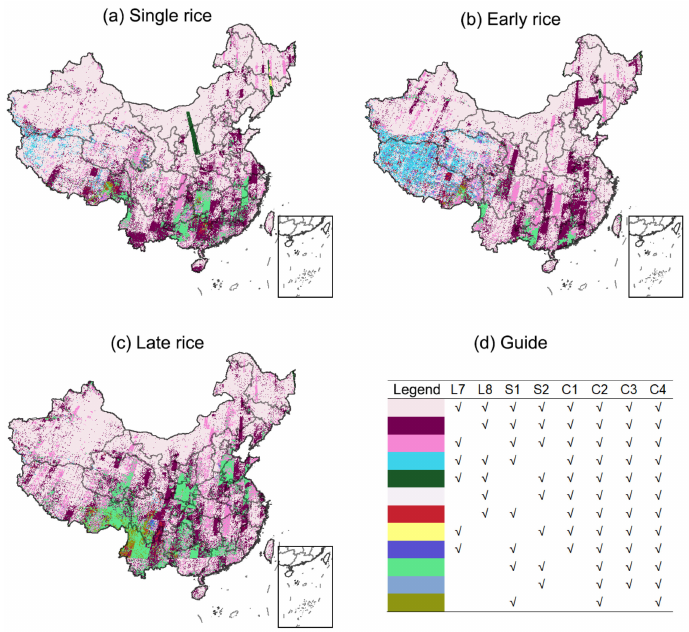
Figure 9. Guide to the best and most suitable satellite selection for ( a ) single rice, ( b ) early rice, and ( c ) late rice mapping. We considered the existing common remote sensing data, future conceived satellite sensors, and their combinations. L7, Landsat-7; L8, Landsat-8; S1, Sentinel 1; S2, Sentinel 2; C1, Landsat-7 and Landsat-8; C2, Sentinel-1 and Sentinel-2; C3, Landsat-7, Landsat-8, and